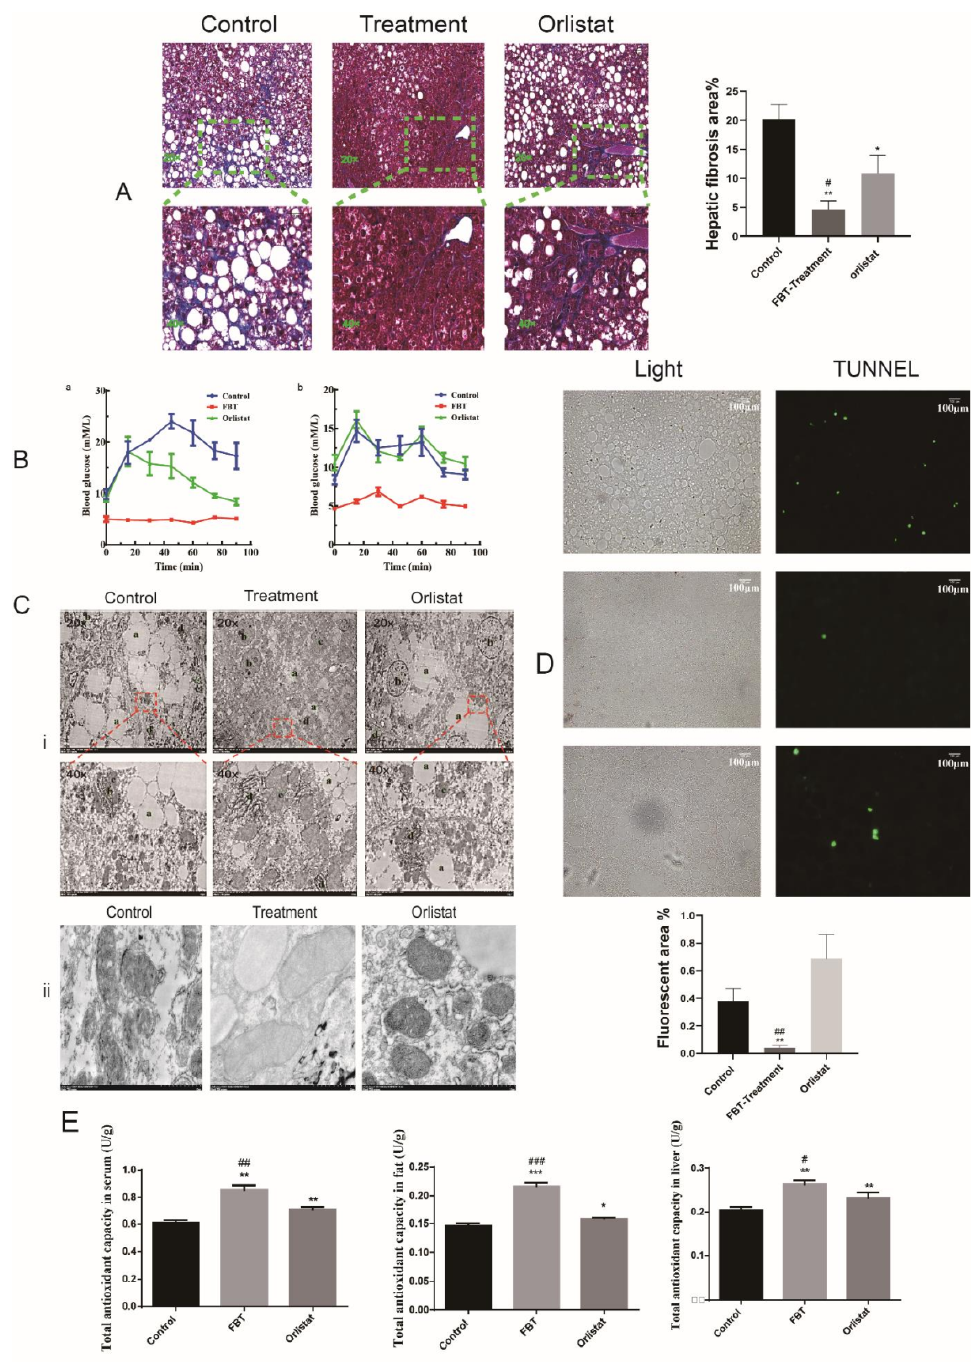
Figure 6. ( A ) Stained by Masson’s trichrome represents the fibrotic area, and the fibrotic area was quantified using ImageJ. The blue area is the liver tissue; The red area is the cytoplasm; The purple area is the nucleus. ( B ) Changes in blood glucose concentration within 90 min in insulin resistance and glucose tolerance tests in different groups of mice. ( C ) i; Effects of FBT on the ultrastructure of liver tissue in obese mice under a transmission electron microscope. a; lipid particles, b; nucleus, c; mitochondria. d; endoplasmic reticulum. ii; Ultrastructure of mitochondria in different treatment groups. ( D ) Mouse liver apoptosis and necrotic cells were labeled by TUNEL fluorescence staining, and the fluorescence area was quantified by ImageJ. ( E ) Detection of total antioxidant activity in the liver, fat and serum of mice. * p < 0.05, ** p < 0.01, and *** p < 0.0001 versus the control group; # p < 0.05, ## p < 0.01, and ### p < 0.0001 versus the orlistat